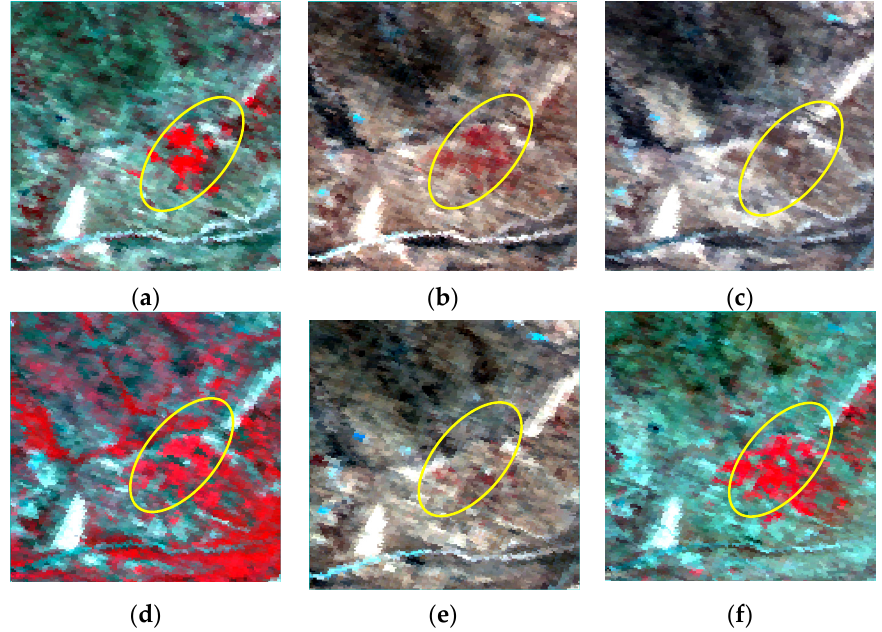
Figure 7. MODIS images from the AHB dataset reflecting changes in phenology in rural and moun- tainous areas. Dates: ( a ) 30 May 2013; ( b ) 10 February 2014; ( c ) 17 March 2015; ( d ) 26 August 2016;